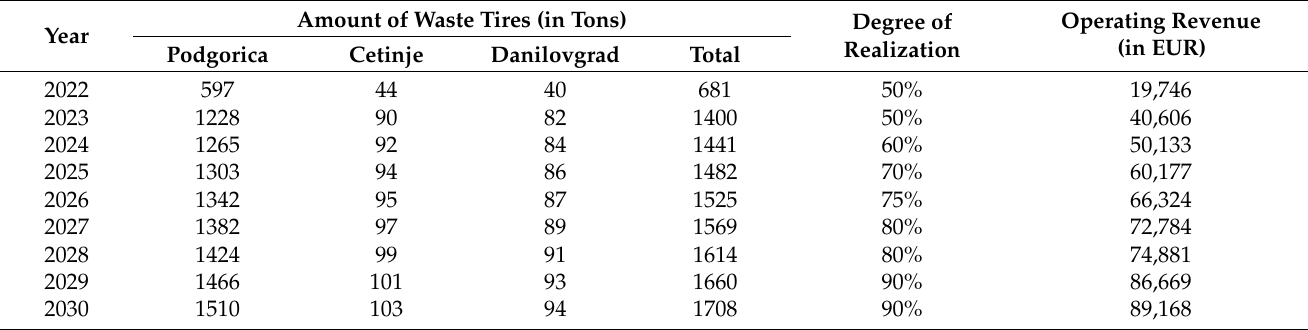
Table 6. Project’s revenue projection (in EUR).